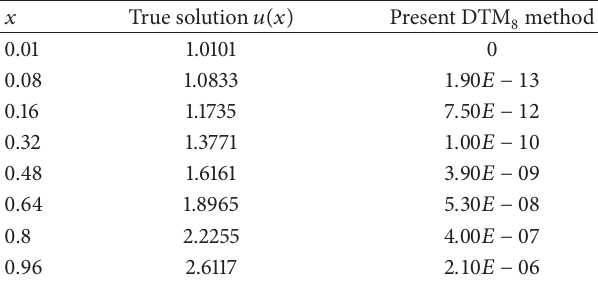
Table 2: Comparison of relative errors of the present method for Example 3.